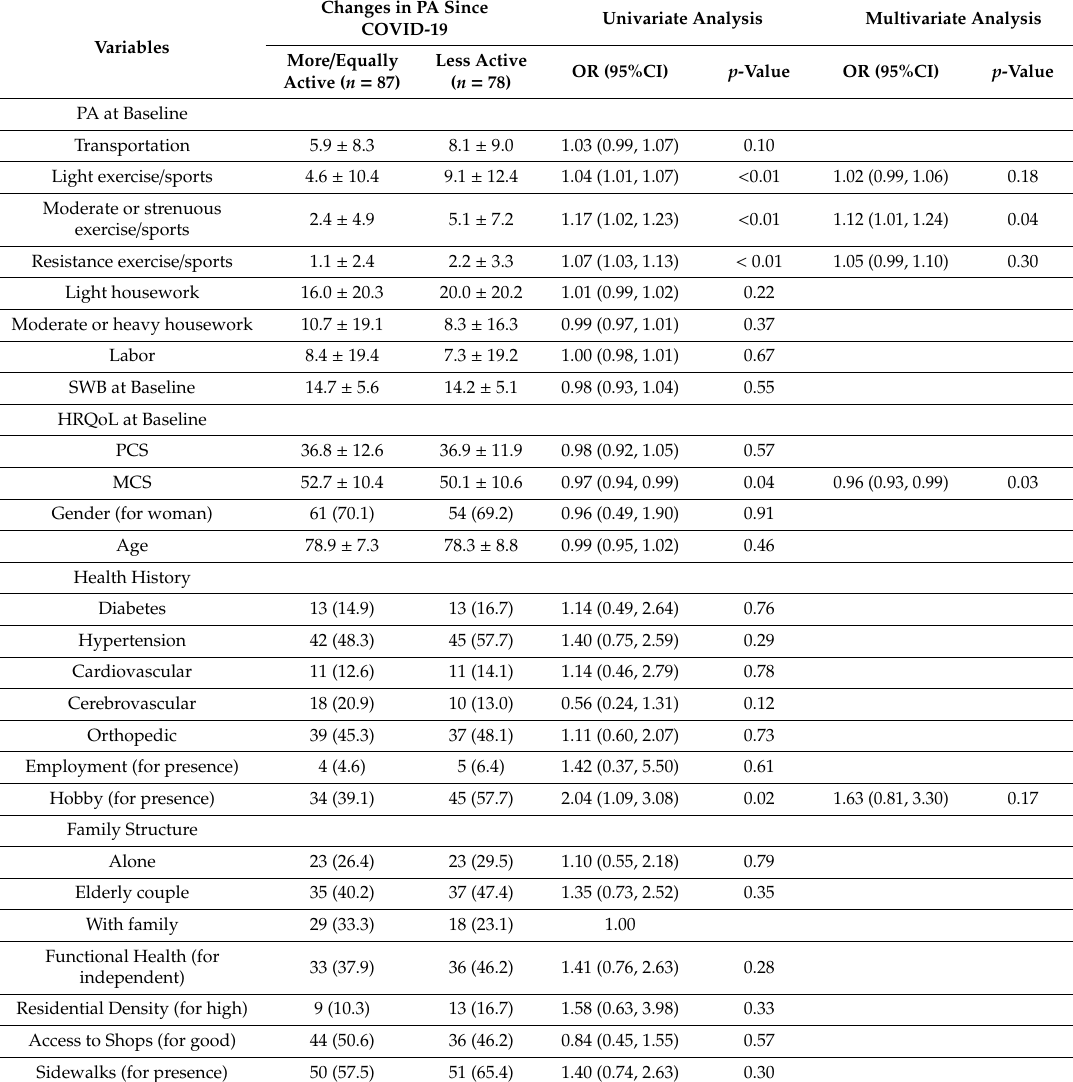
Table 3. Risk Factors Associated with Decreased